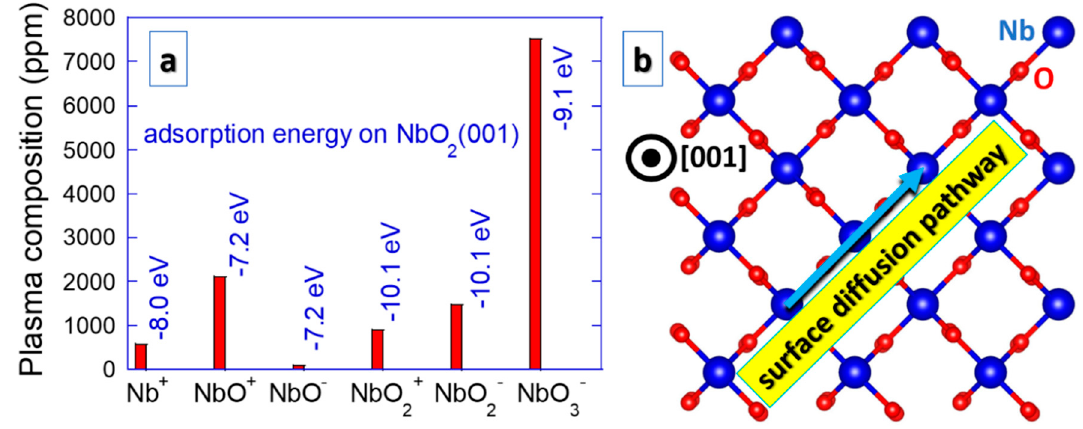
Figure 2. Composition of Nb–O 2 –Ar sputtering plasma regarding Nb containing species [44] ( a ). Adsorption energies on NbO 2 (001) surfaces ( a ) are provided together with a predominant diffusion pathway [44] ( b ).